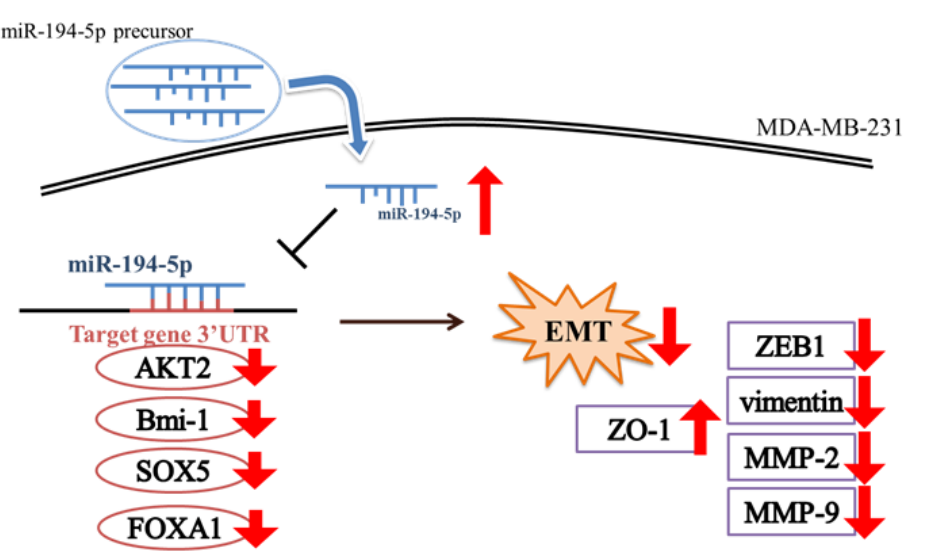
Figure 7. Schematic diagram of miR-194-5p regulating cell migration by ZEB1 in MDA-MB-231 cells.